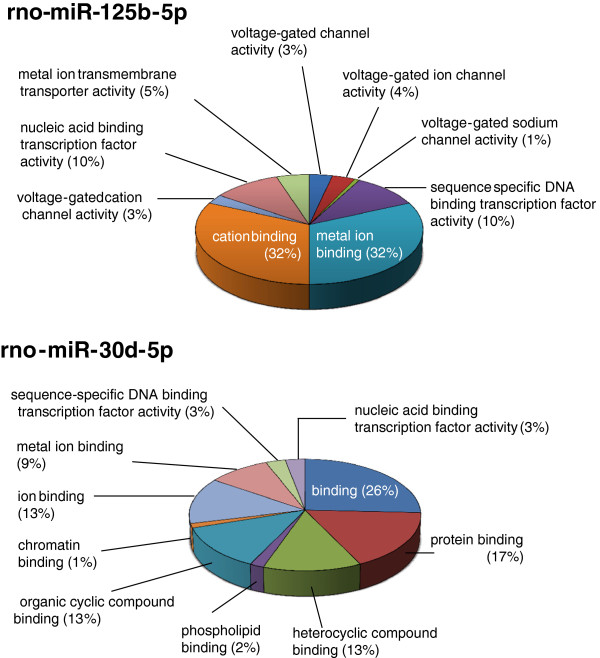
Pie charts show the Gene Ontology (GO) molecular function terms that are enriched compared to the overall genome, among the mRNA targets predicted by the TargetScan algorithm for miR-125b-5p (n = 451) and miR-30d-5p (n = 1094).